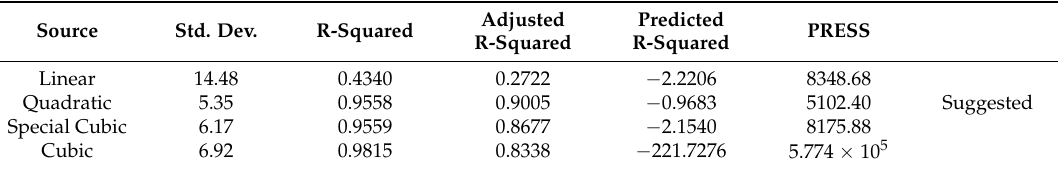
Table 4. Variance analysis results of various models.